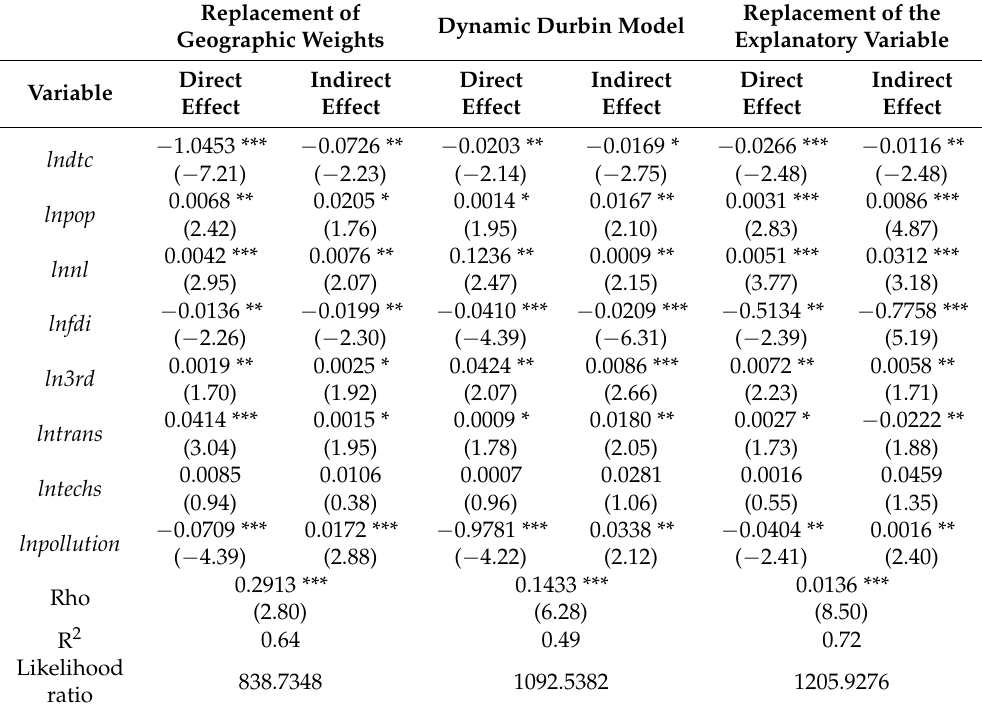
Table 8. Robustness